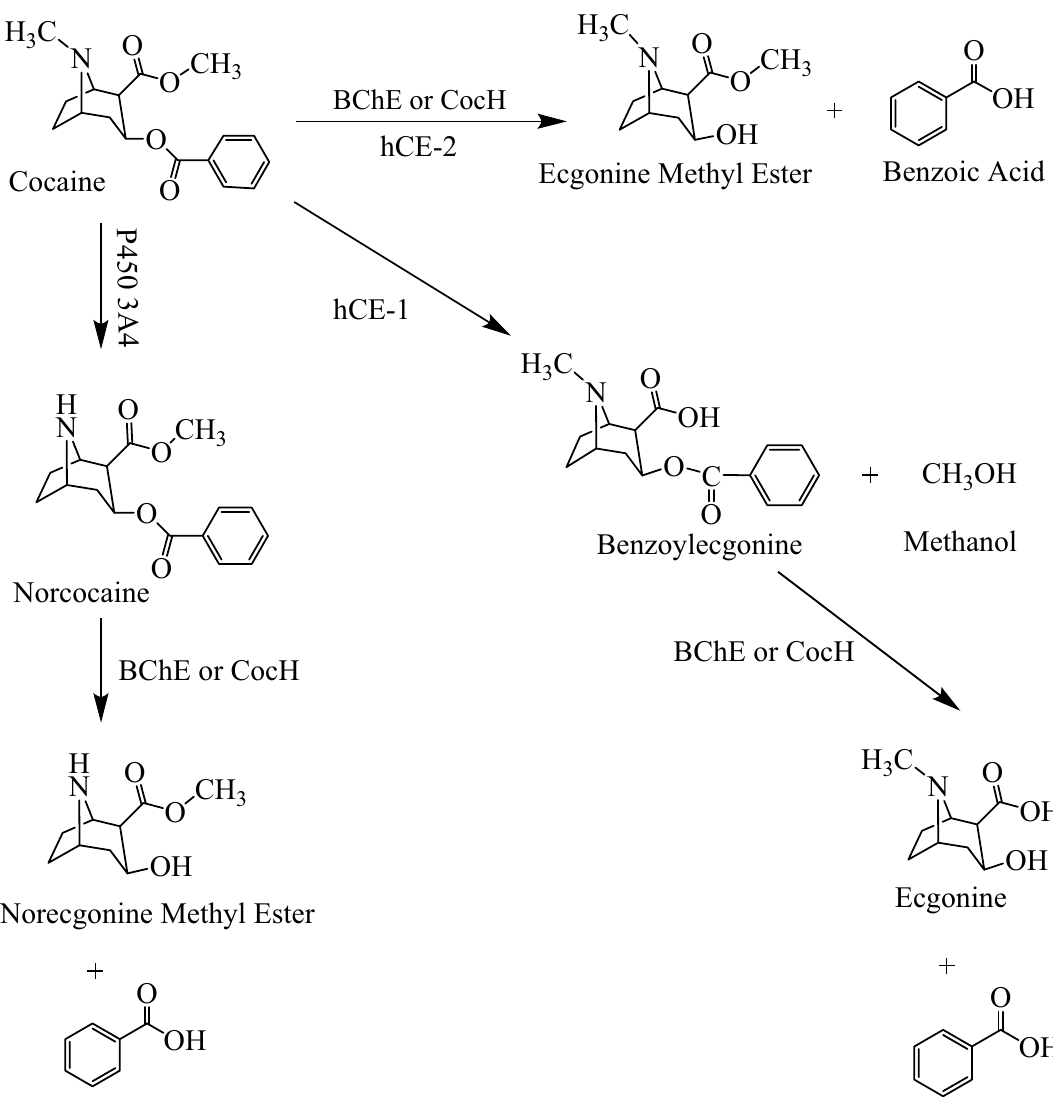
Figure 1. Metabolic pathways of cocaine in human. The metabolic enzymes include the endogenous enzymes butyrylcholinesterase (BChE), liver carboxylesterase-1 (hCE-1), liver carboxylesterase-2 (hCE-2), and cytochrome (CYP) P450 3A4, as well as exogenous enzyme cocaine hydrolase (CocH) if a CocH is used in clinic in the